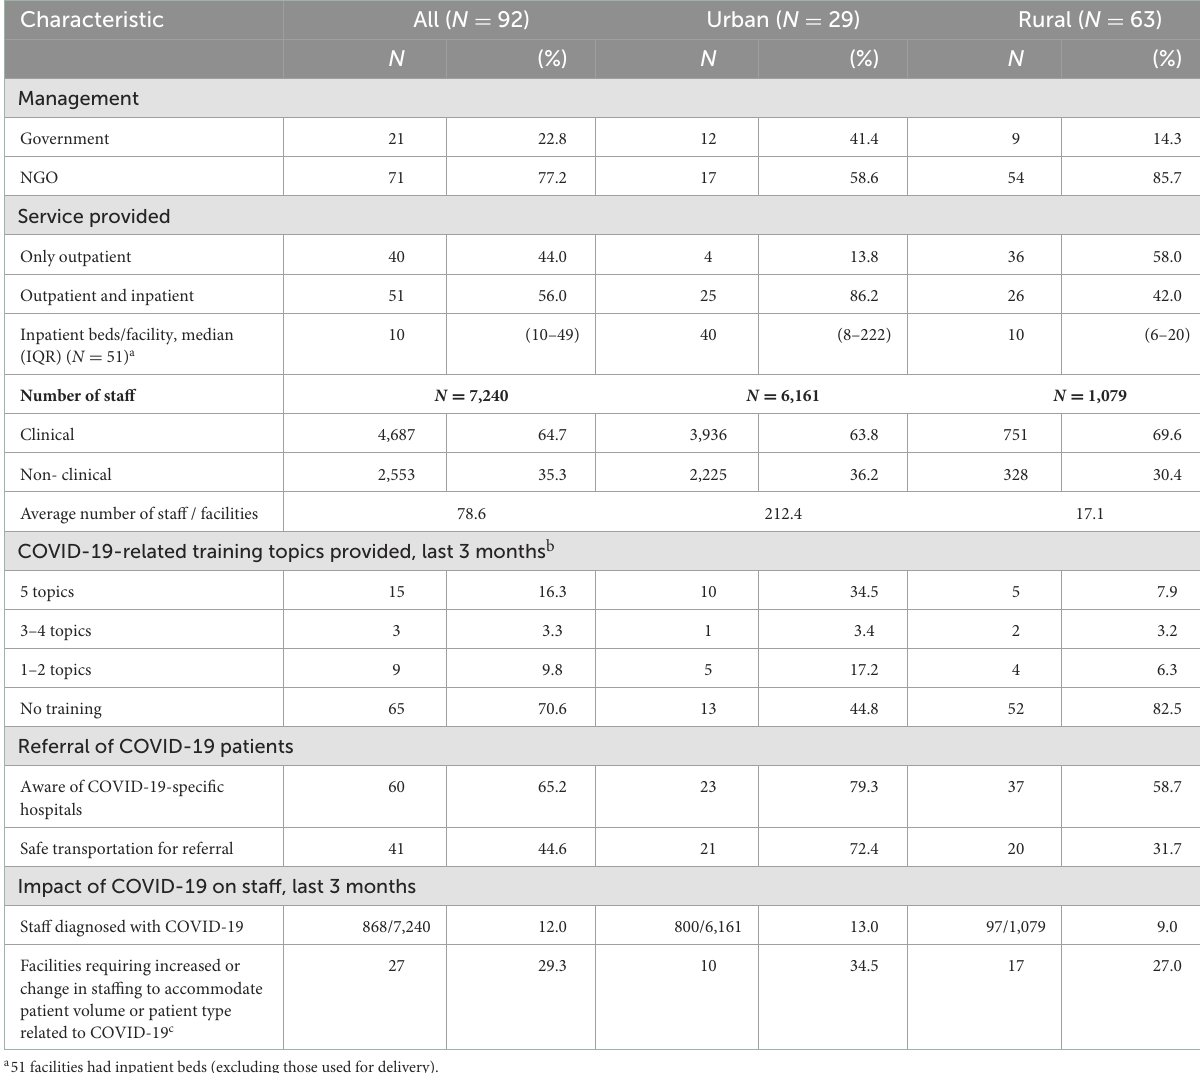
TABLE 1 Characteristics of health care facilities and changes during November 2021-January 2022, Afghanistan ( N = 92).